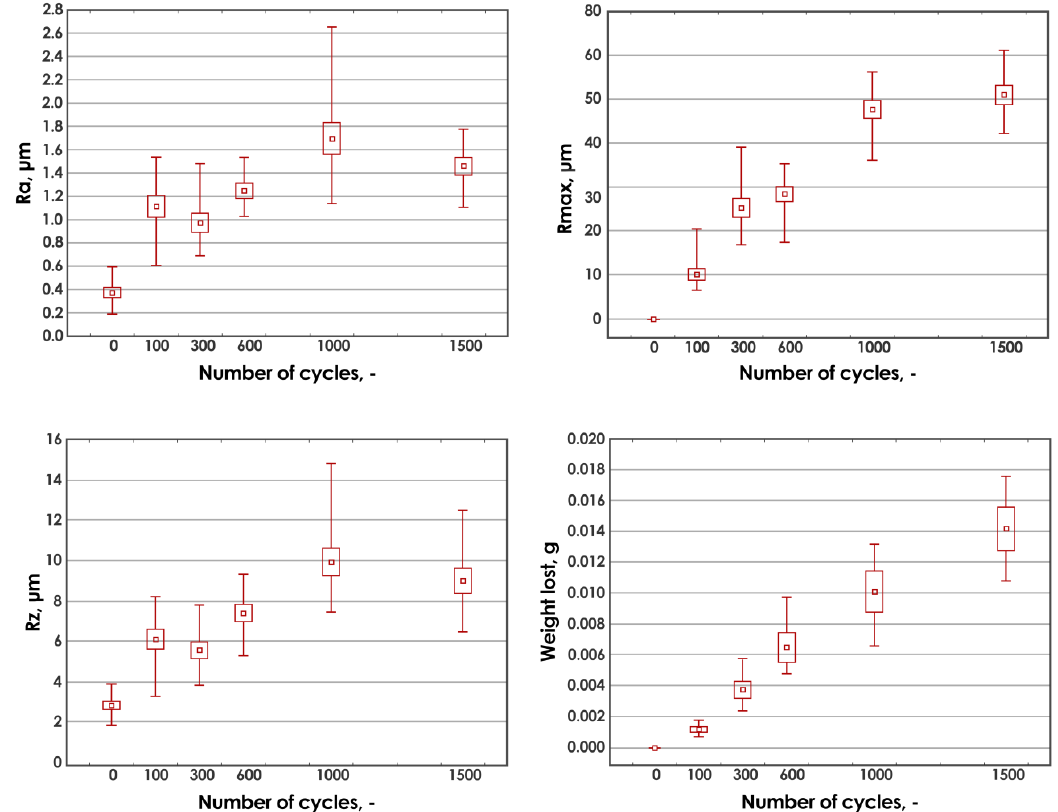
Figure 5. Dependencies of the arithmetical mean height (R a ), the maximum height of the profile (R z ), and maximum roughness depth (R max ) parameters and weight loss on the number of wear cycles.